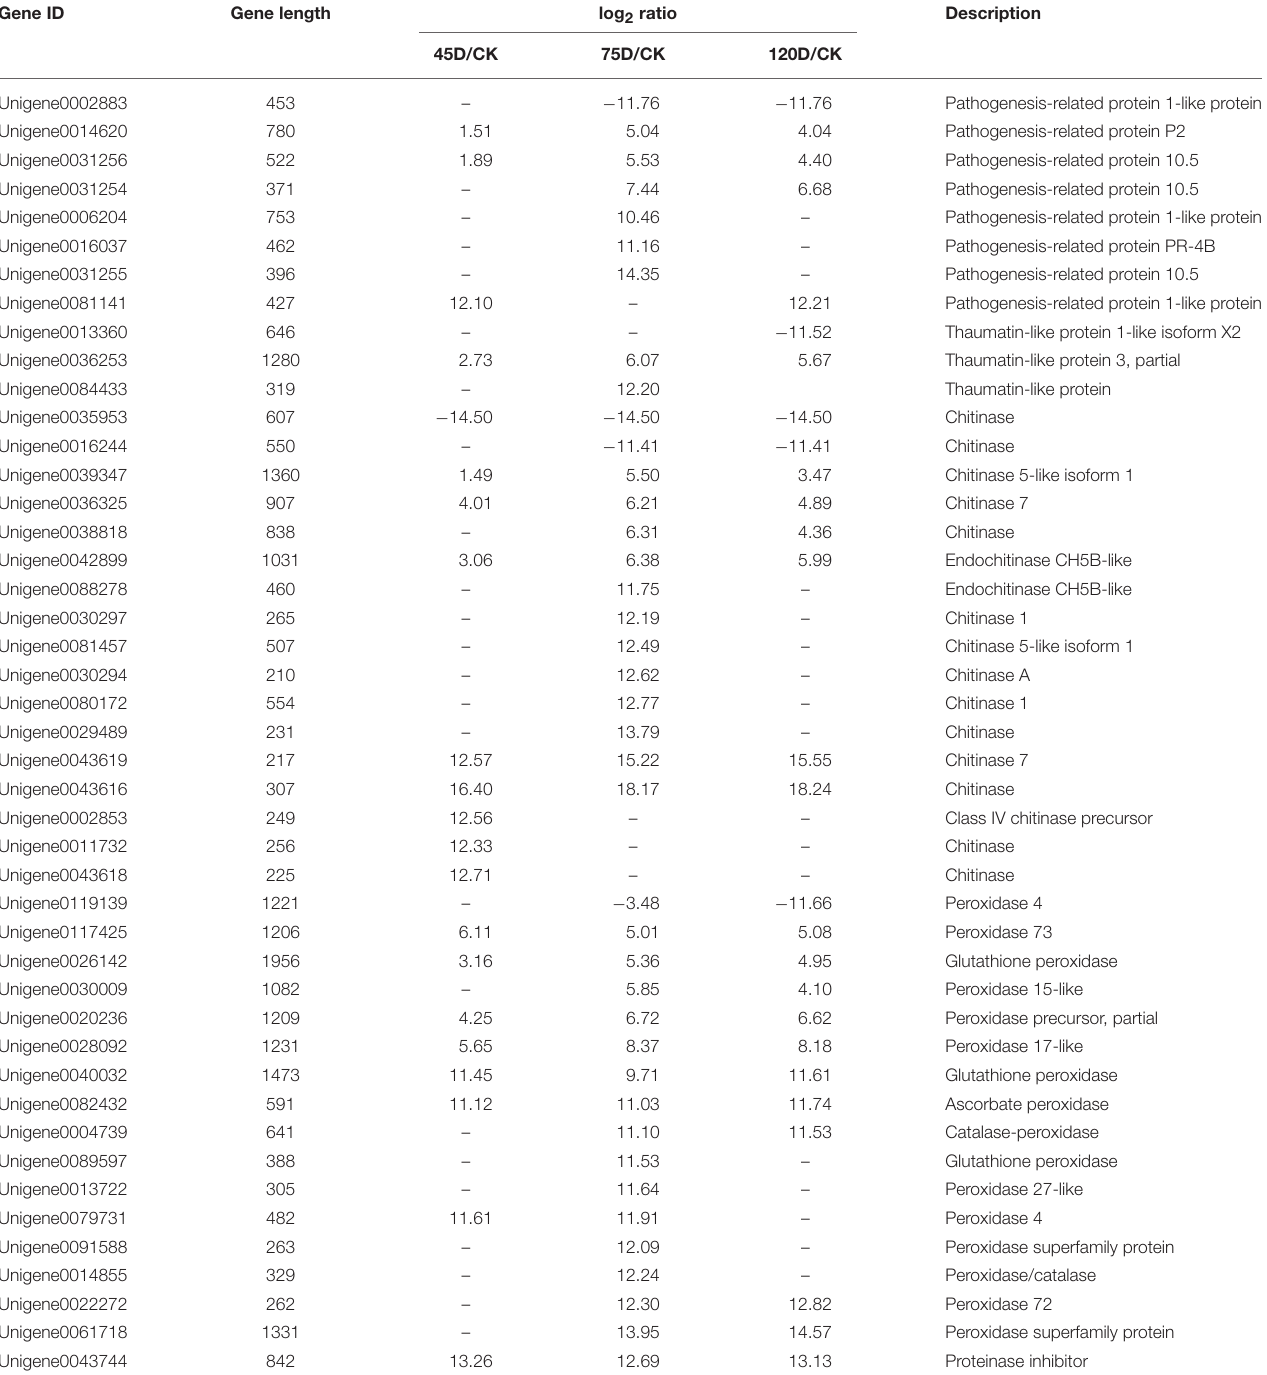
TABLE 3 | Summary of selected F. mangiferae -responsive pathogenesis-related